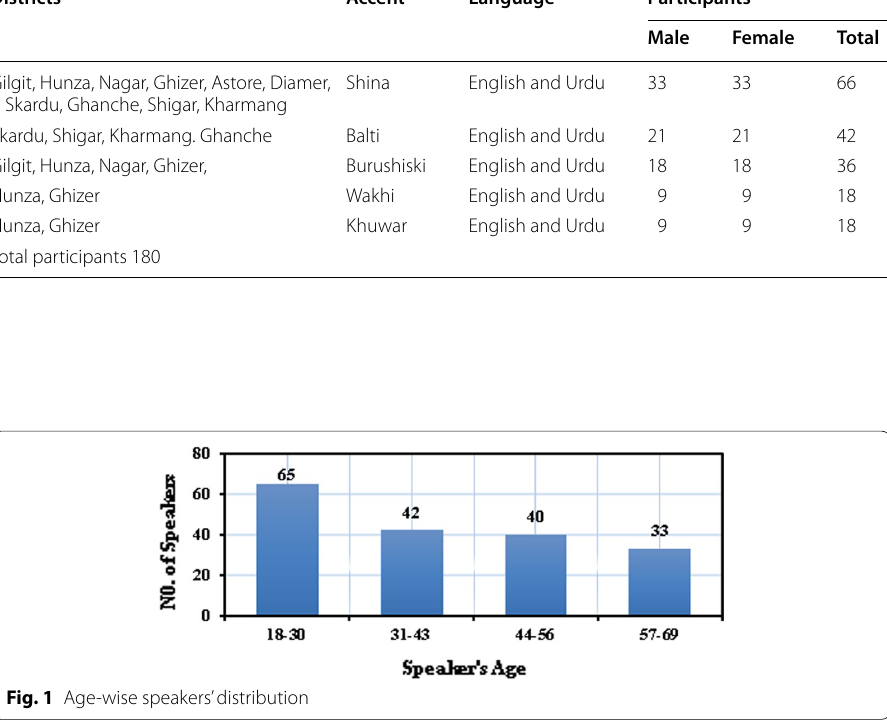
Table 1 District wise speaker selection Districts Accent